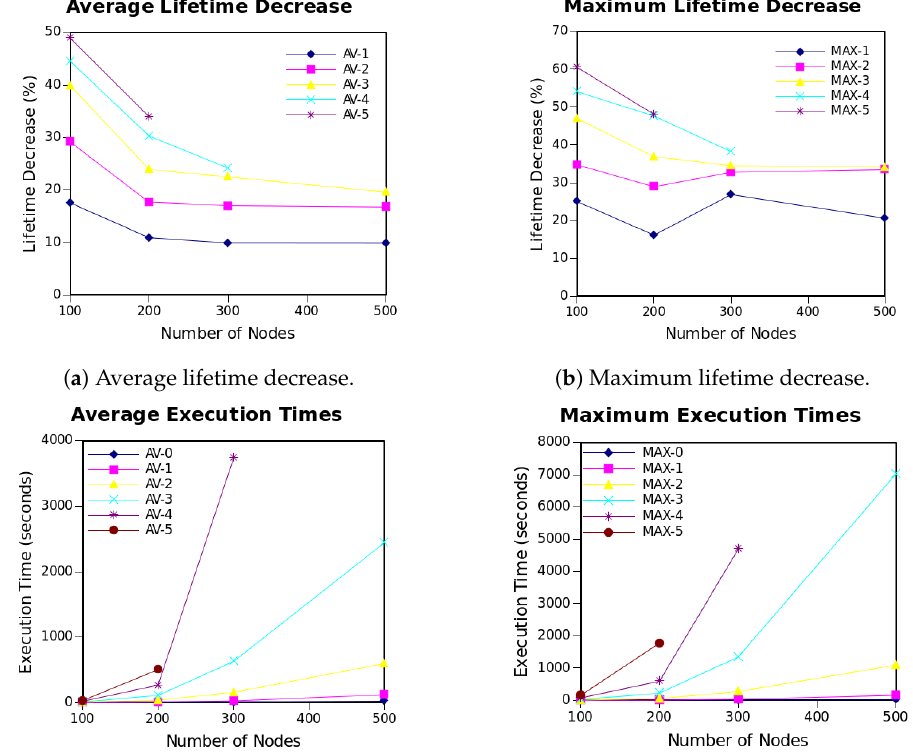
Figure 5. Average and maximum lifetime decrease values and execution times for networks with nodes distributed in a 200 m radius